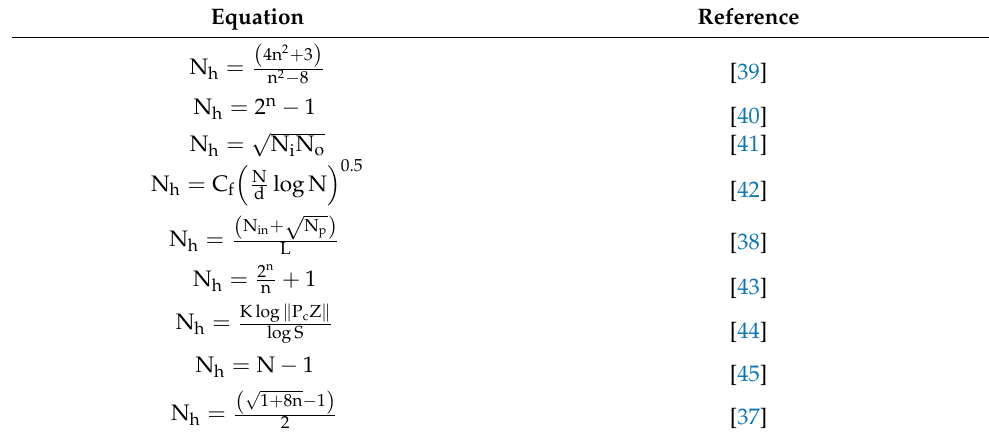
Table 1. Equations to determine the number of hidden neurons required.